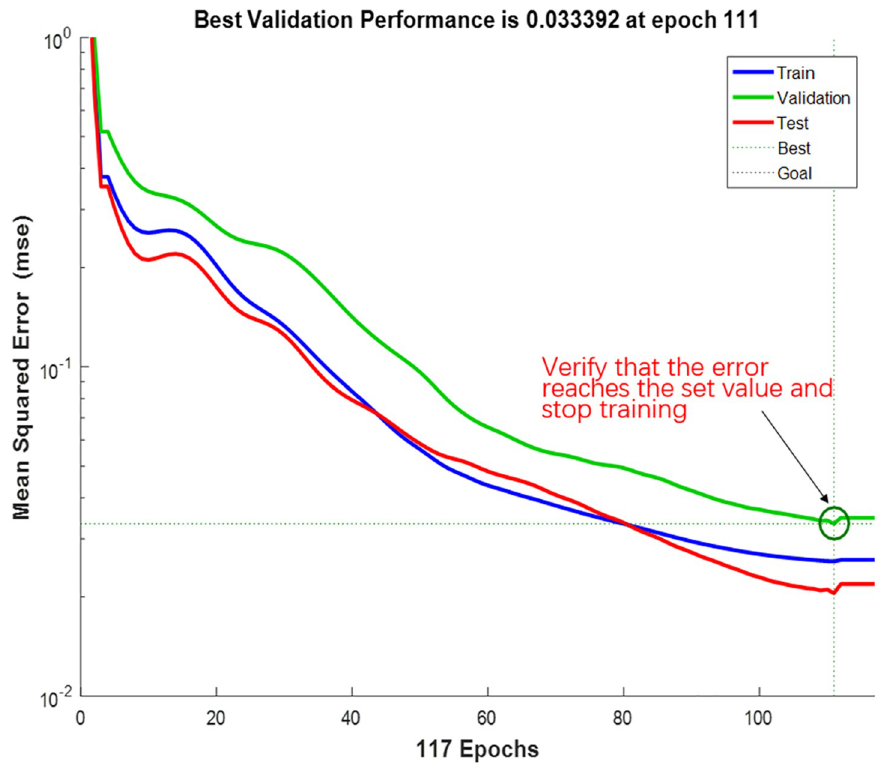
Fig 21. Performance of the